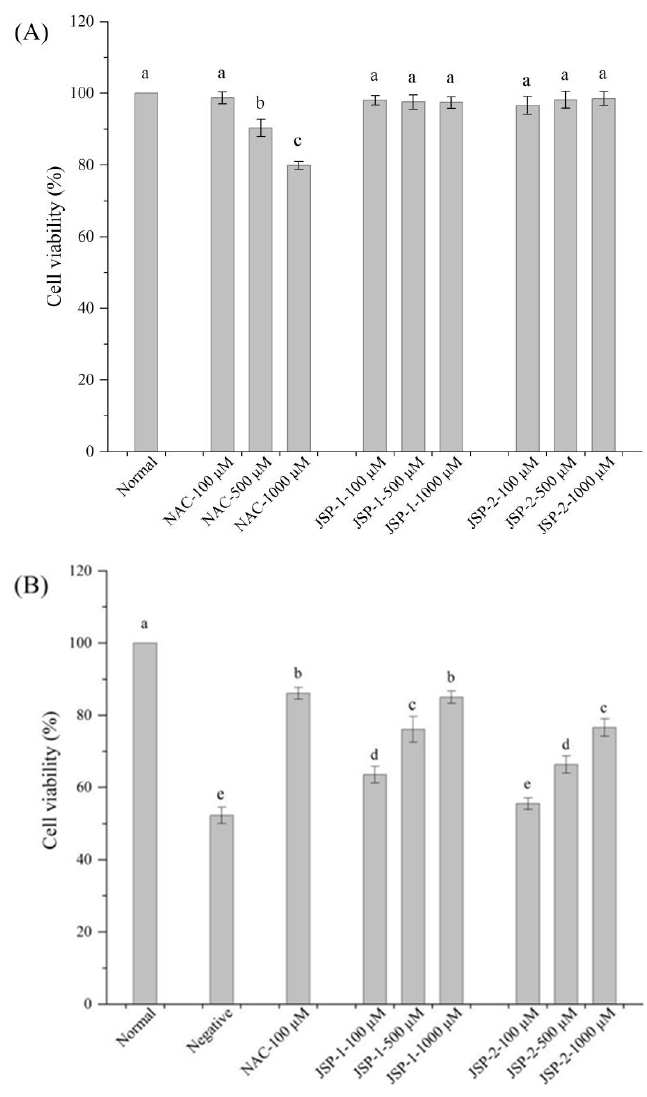
Figure 3. Hypoglycemic effect of JSP sub-fractions. ( A ) Cytotoxicity of JSP sub-fractions and N-acetyl-L-cysteine (NAC) on islet cells; ( B ) protective effect of JSP sub-fractions and NAC on high-glucose-induced hyperglycemic rat pancreatic islet (RIN-m5F) cells injury. Values within each sample, denoted by various letters in the diagram, were statistically different, p < 0.05. Table 1. JSP-1 and JSP-2 molecular weight and monosaccharide composition.